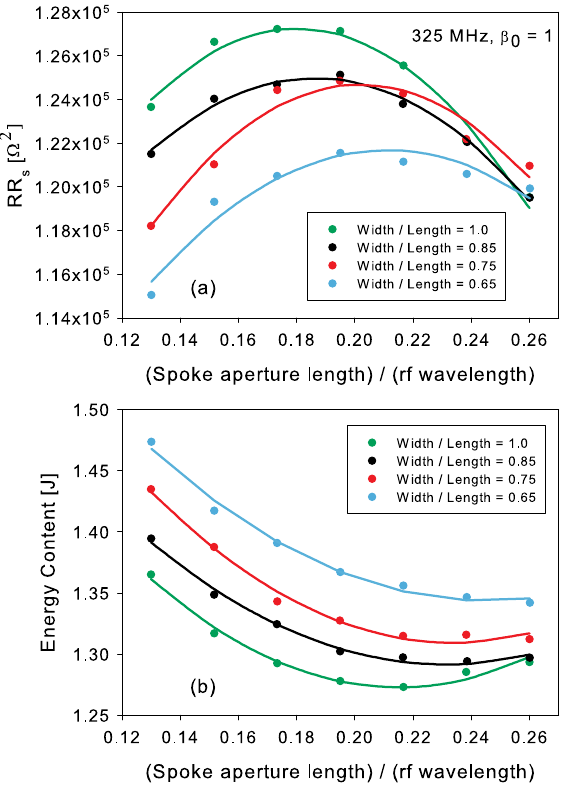
FIG. 20. Dependence of (a) RR s and (b) energy content (at 1 MV = m ) on spoke aperture